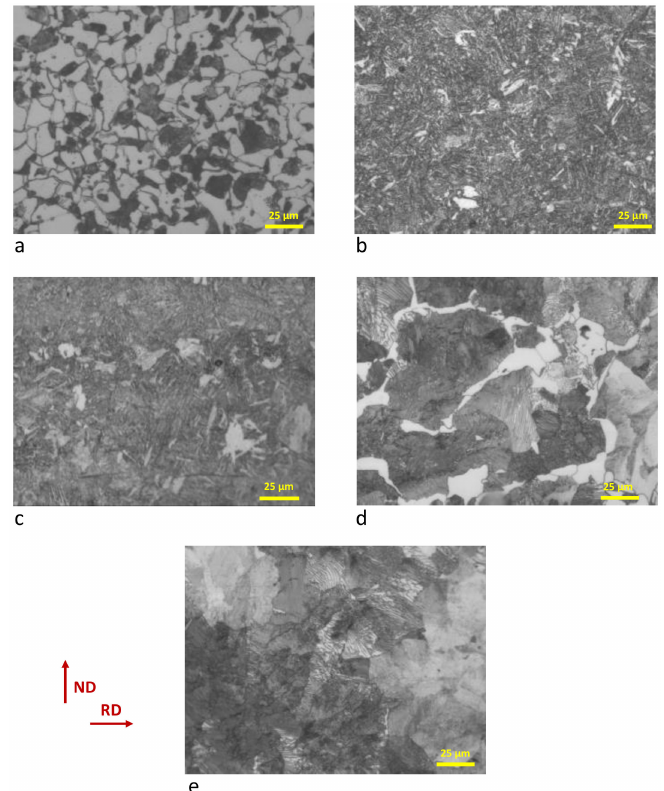
Figure 2. Optical microscopy images for the following alloys: ( a ) 16MnCr5, ( b ) 41Cr4, ( c ) 42CrMo4, ( d ) SAE1055 and ( e )